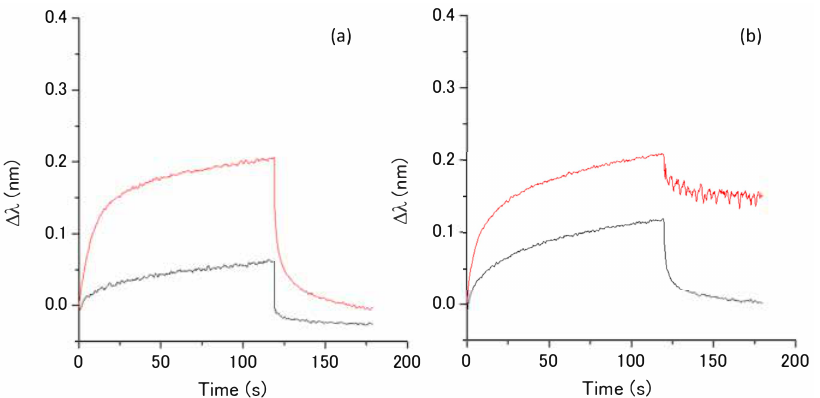
Figure 4. Mannose binding ability of ConA eluent from the first peak ( a ) and in second half peak ( b ). Each sensorgram shows binding change before (black) and after (red) treatment with hydrated